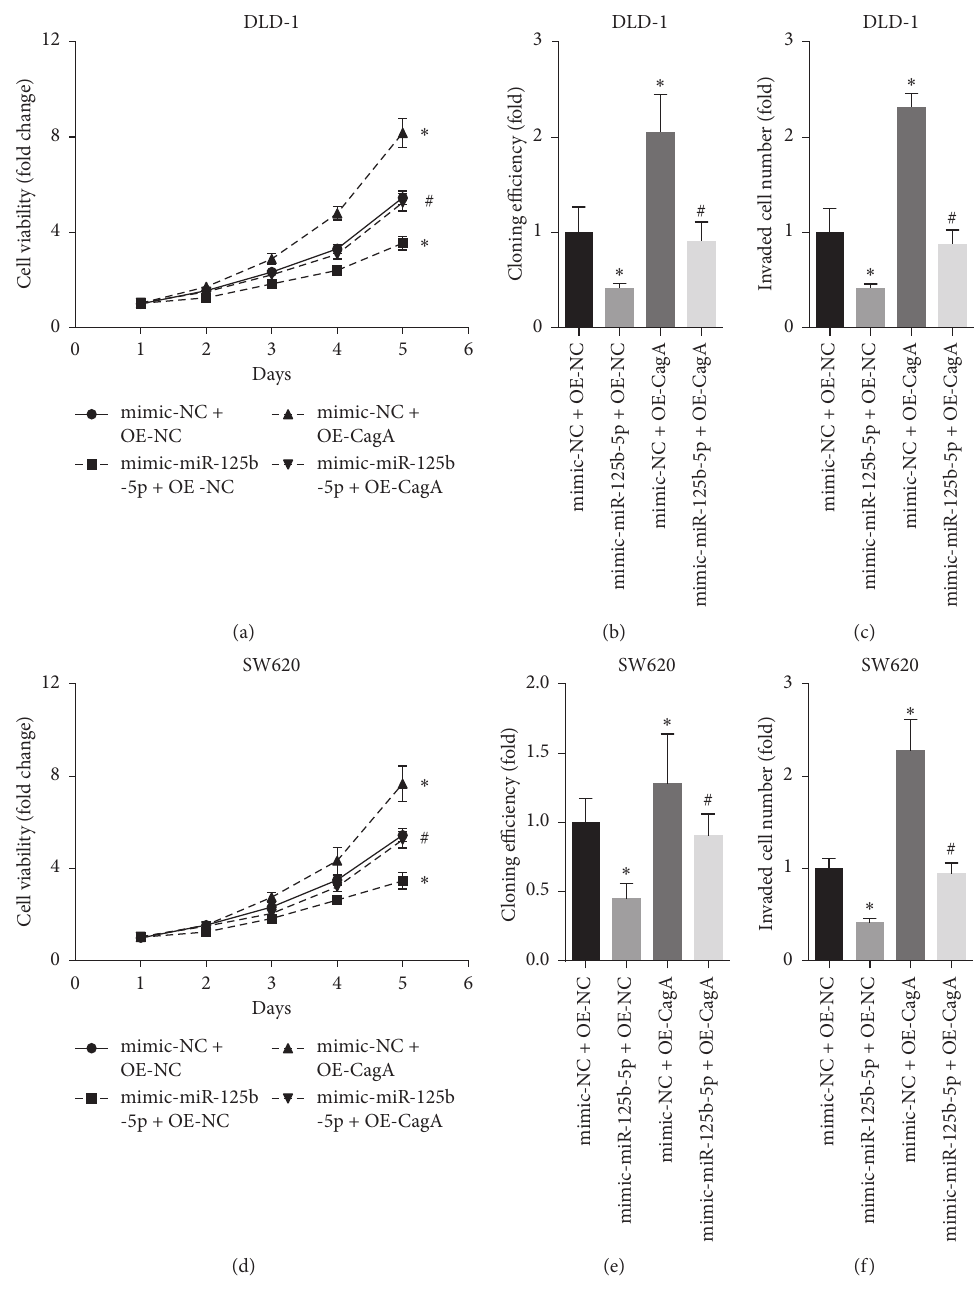
Figure 3: CagA overexpression promotes, while miR-125b-5p inhibits, the proliferation and invasion of colon cancer cells. (a) and (d) represent that on the fifth day, transfection of CagA plasmid significantly increased, while transfection of miR-125b-5p significantly decreased the viability of both DLD-1 (a) and SW620 (d) cells. (b) and (e) represent the transfection of CagA plasmid significantly increased, while transfection of miR-125b-5p significantly decreased the proliferation of both DLD-1 (b) and SW620 (e) cells. (c) and (f) represent the transfection of CagA plasmid significantly increased, while transfection f miR-125b-5p significantly decreased the invasion of DLD-1 (c) and SW620 (f) cells. ∗ p < 0 . 05, compared with mimic-NC+OE-NC, and # p < 0 . 05, compared with mimic-NC+OE-CagA